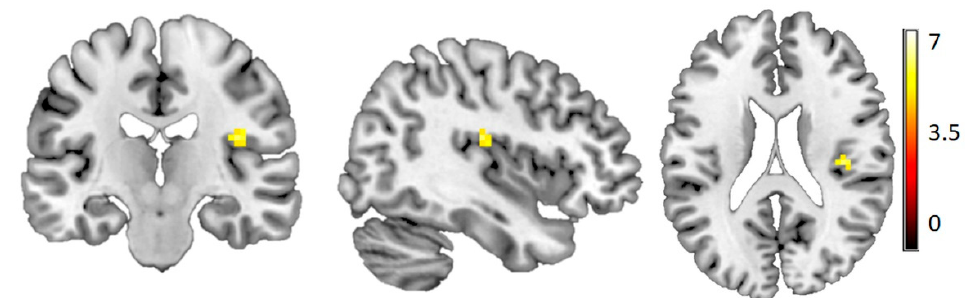
Figure 2. More activation in the posterior insula during slow brushing compared to fast brushing. In all participants, [39–1920] t = 6.25, Z = 5.79, FWE corrected at the whole-brain level p < 0.05, color scale depicts t -values for the contrast slow > fast.